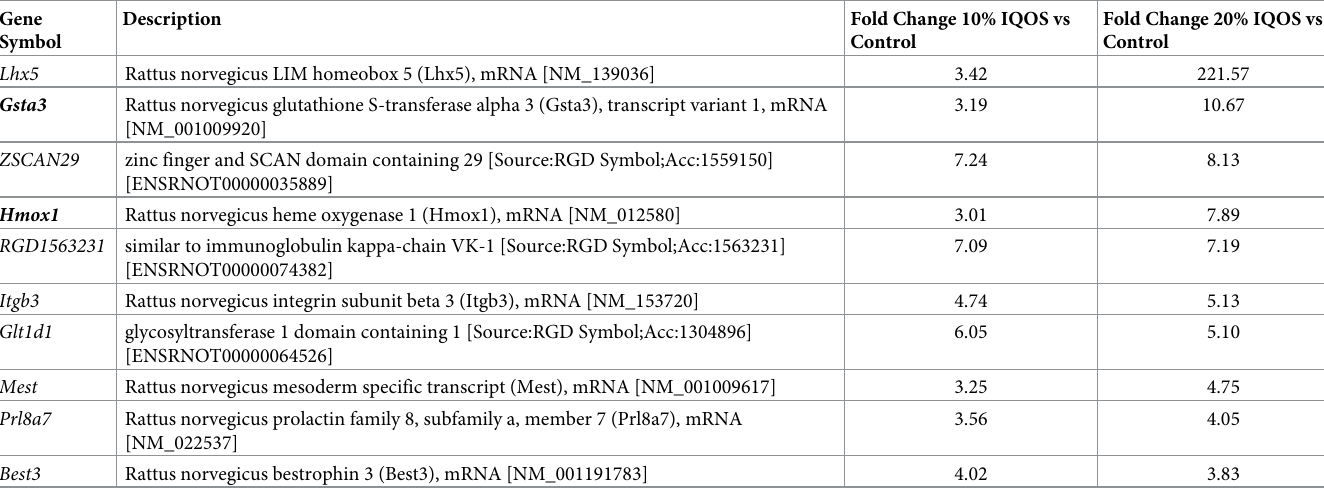
Table 1. Top ten genes upregulated by 20% IQOS CSE at 6 h after exposure. Gene